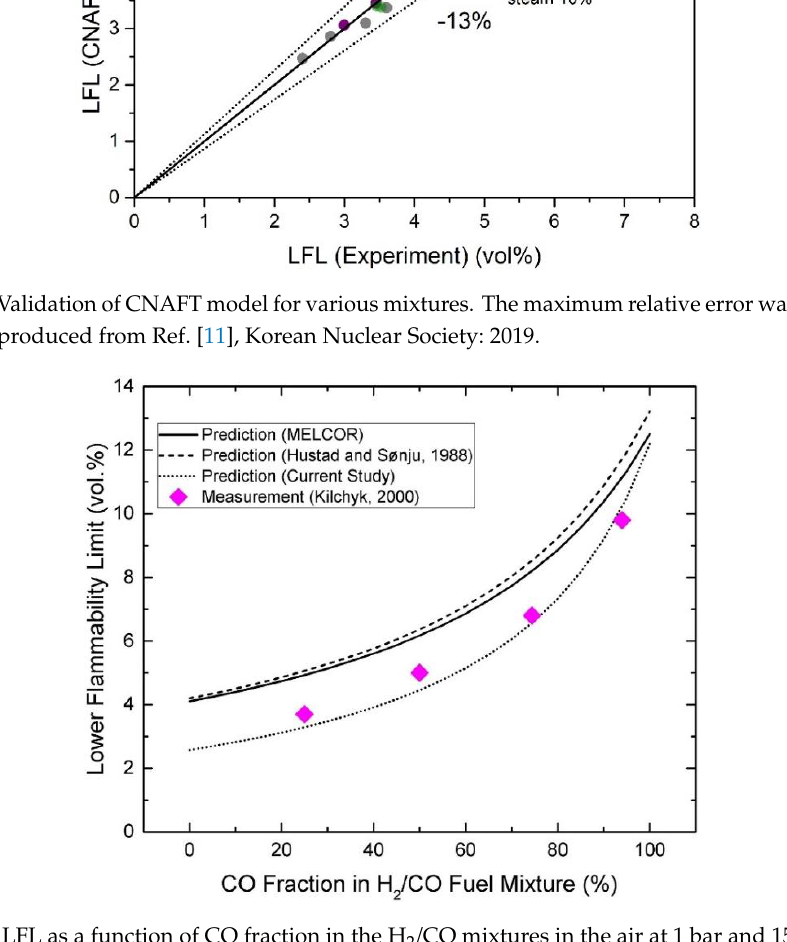
Figure 22. LFL as a function of CO fraction in the H 2 /CO mixtures in the air at 1 bar and 150 °C [54].